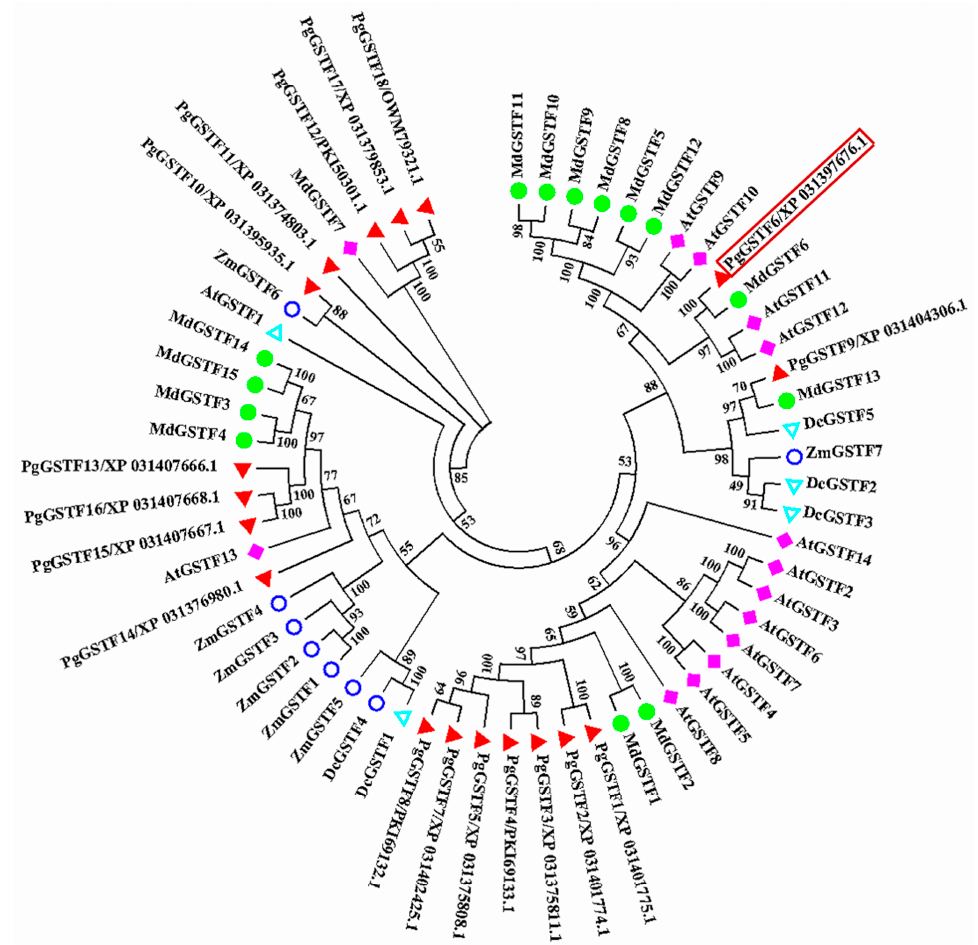
Figure 2. Phylogenetic tree of GSTF proteins in pomegranate, Arabidopsis , apple, dragon’s blood tree, and maize. The 18 pomegranate, 15 apple, 14 Arabidopsis , 5 dragon’s blood tree, and 7 maize GSTF protein sequences were aligned using ClustalW. The long red rectangular box represents PgGSTF6. The phylogenetic tree was constructed based on the neighbor-joining algorithm.